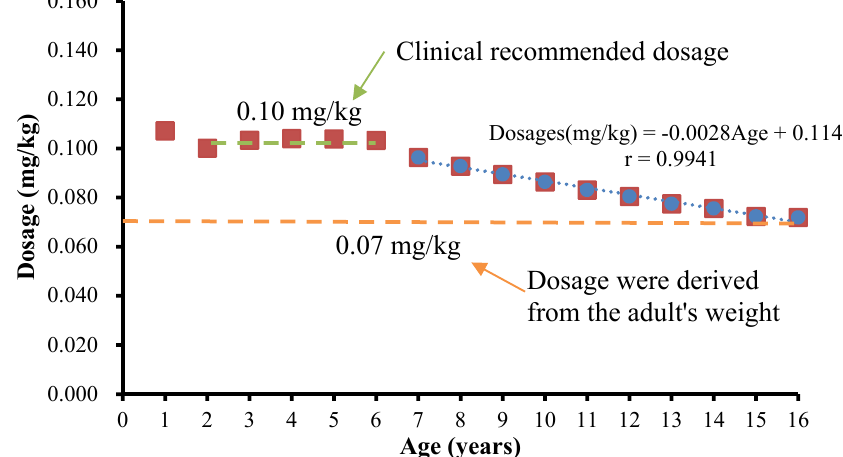
Figure 4. The relationship between the dosage derived from the PBPK model constructed by enzyme expression and the recommended dosage derived by body weight.